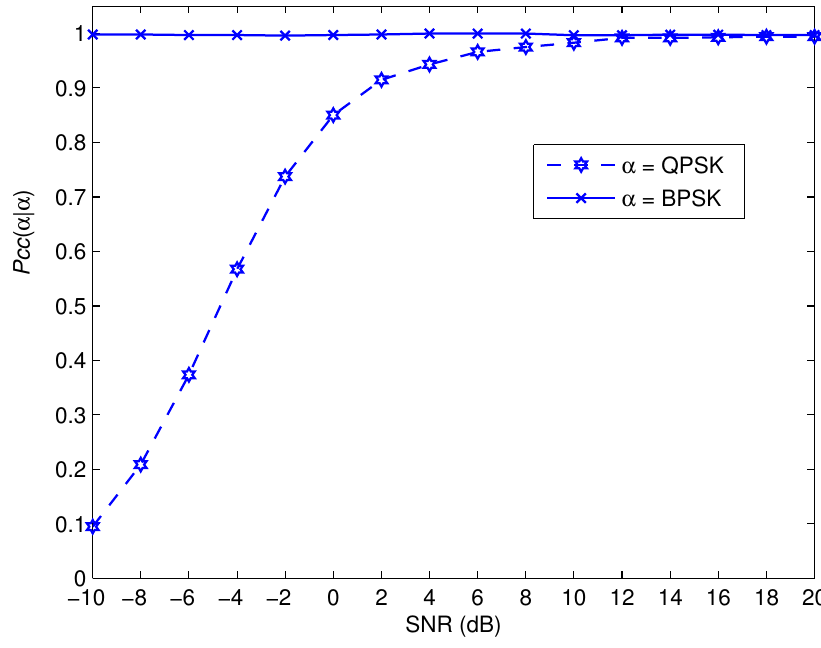
Figure 7. Pcc ( α | α ) for the modulation group of θ 1